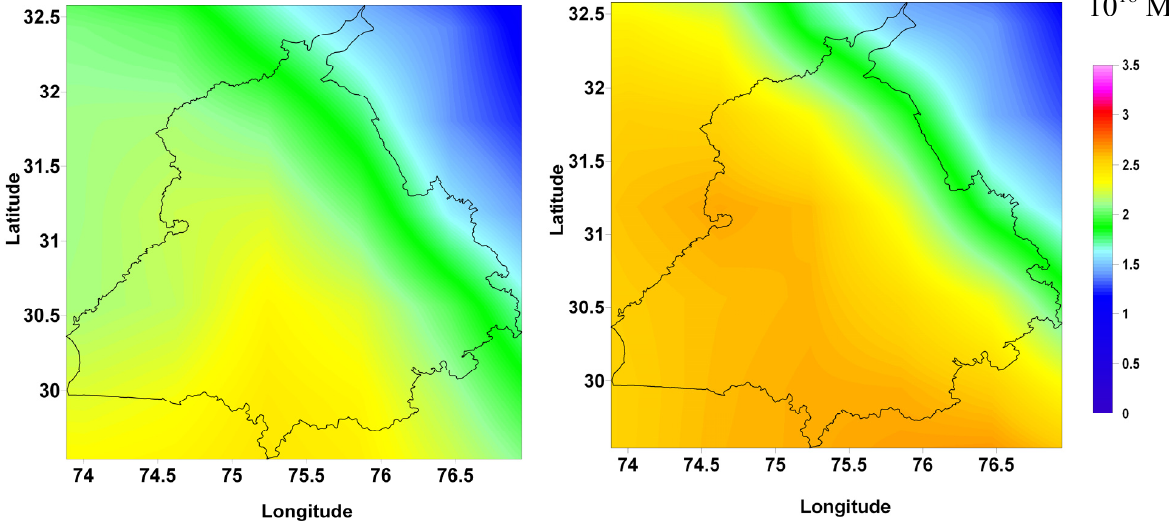
Fig. 11. Spatial variation of MOPITT CO over Punjab state during October 2006 and 2007.